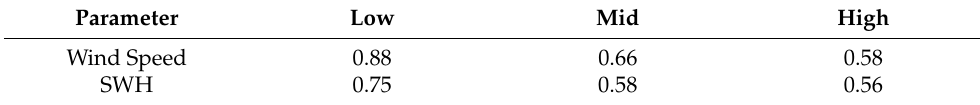
Table 2. Pearson correlations between ERA5 parameters and mapped Doppler spread. Parameter